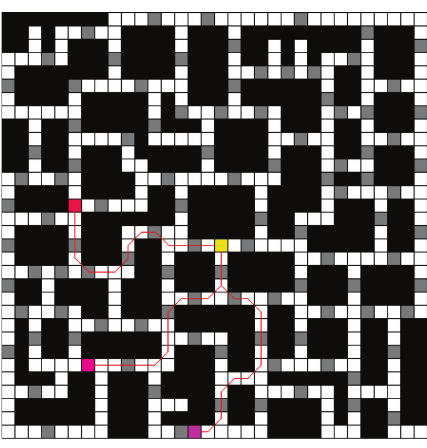
Figure 1: Situation without team AI. Figure 2: Situation with team AI.